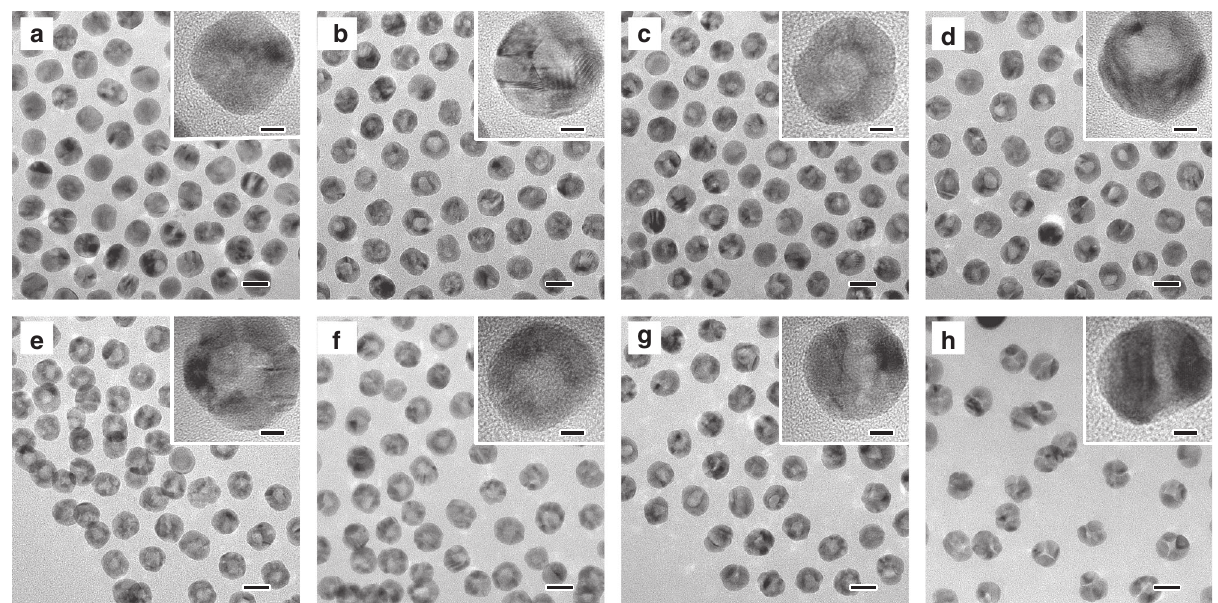
Fig. 3 TEM and HRTEM images of hollow Pd hollow nanocrystals obtained with varied molar ratios of N 2 :O 2 : a 90:10, b 85:15, c 75:25, d 70:30, e 60:40, f 40:60, g 20:80, h 0:100. Scale bars are 20 nm. Scale bars in the insets are 5